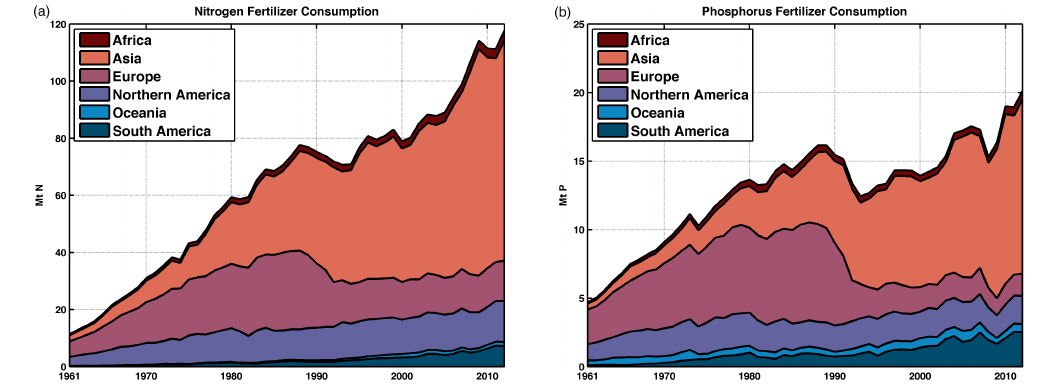
Figure 2. Global (a) nitrogen (N) and (b) phosphorus (P) fertilizer use between 1961 and 2012 split for the different continents in Mt P per year; plotted from FAOSTAT data (FAOSTAT,